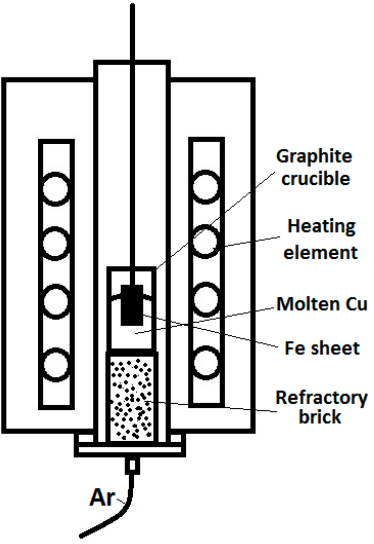
Figure 1. Experimental